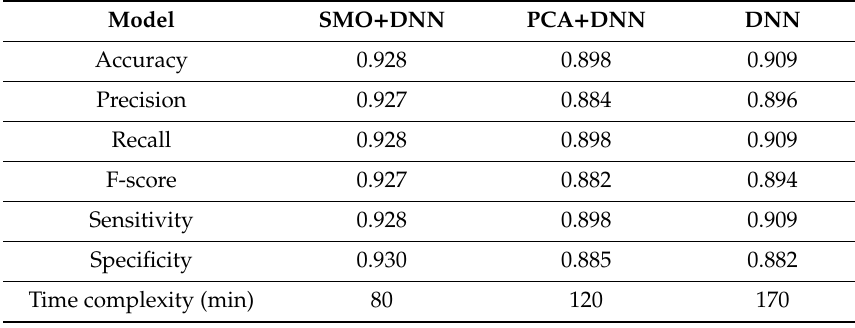
Table 4. Detailed performance evaluation of the SMO-DNN using KDDCup